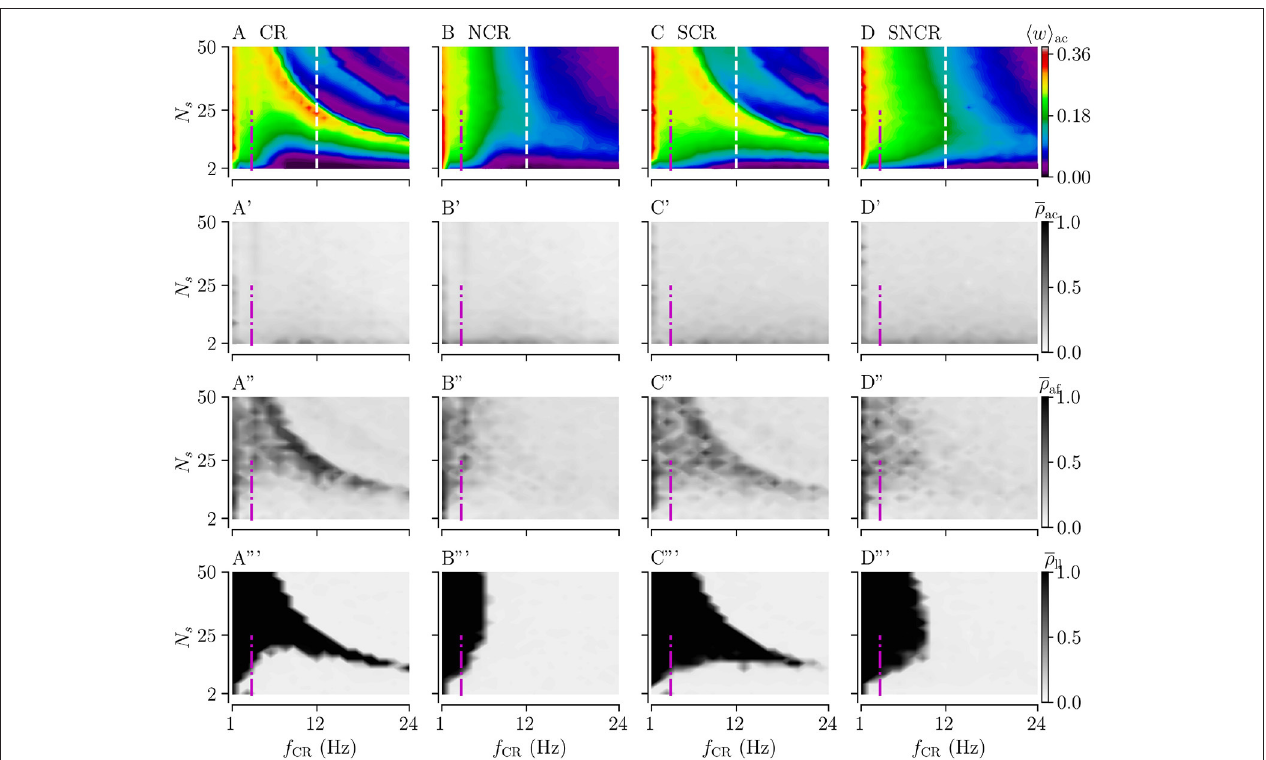
FIGURE 7 | Acute, acute after-, and long-lasting effects of weak stimulation for the four multisite stimulation protocols. Upper (A–D) show simulation results for the acute mean weight, h w i ac ; (A’–D’) show the acute Kuramoto order parameter, ρ ac , time-averaged over the last 10 s of the stimulation duration; (A”–D”) show the acute after-effect measured by the Kuramoto order parameter, ρ af , 10 s after cessation of the stimulation; and the bottom panels (A”’–D”’) show the results for the Kuramoto order parameter, ρ ll , time-averaged over a 10 s time interval 1,000 s after cessation of stimulation. Low values of the Kuramoto order parameter indicate desynchronized activity while high values refer to pronounced in-phase synchronization. The white vertical lines in (A–D) mark a stimulation frequency of f CR = 12 Hz for which we present a detailed analysis of the influence of the stimulation duration T stim in Figure 8 . The frequency of the original synchronous rhythm is approximately 3.5 Hz and it is shown by the magenta dot-dashed vertical lines. Acute mean weights are measured at the end of T stim = 500 s stimulation period. Parameters: A stim = 0.1.